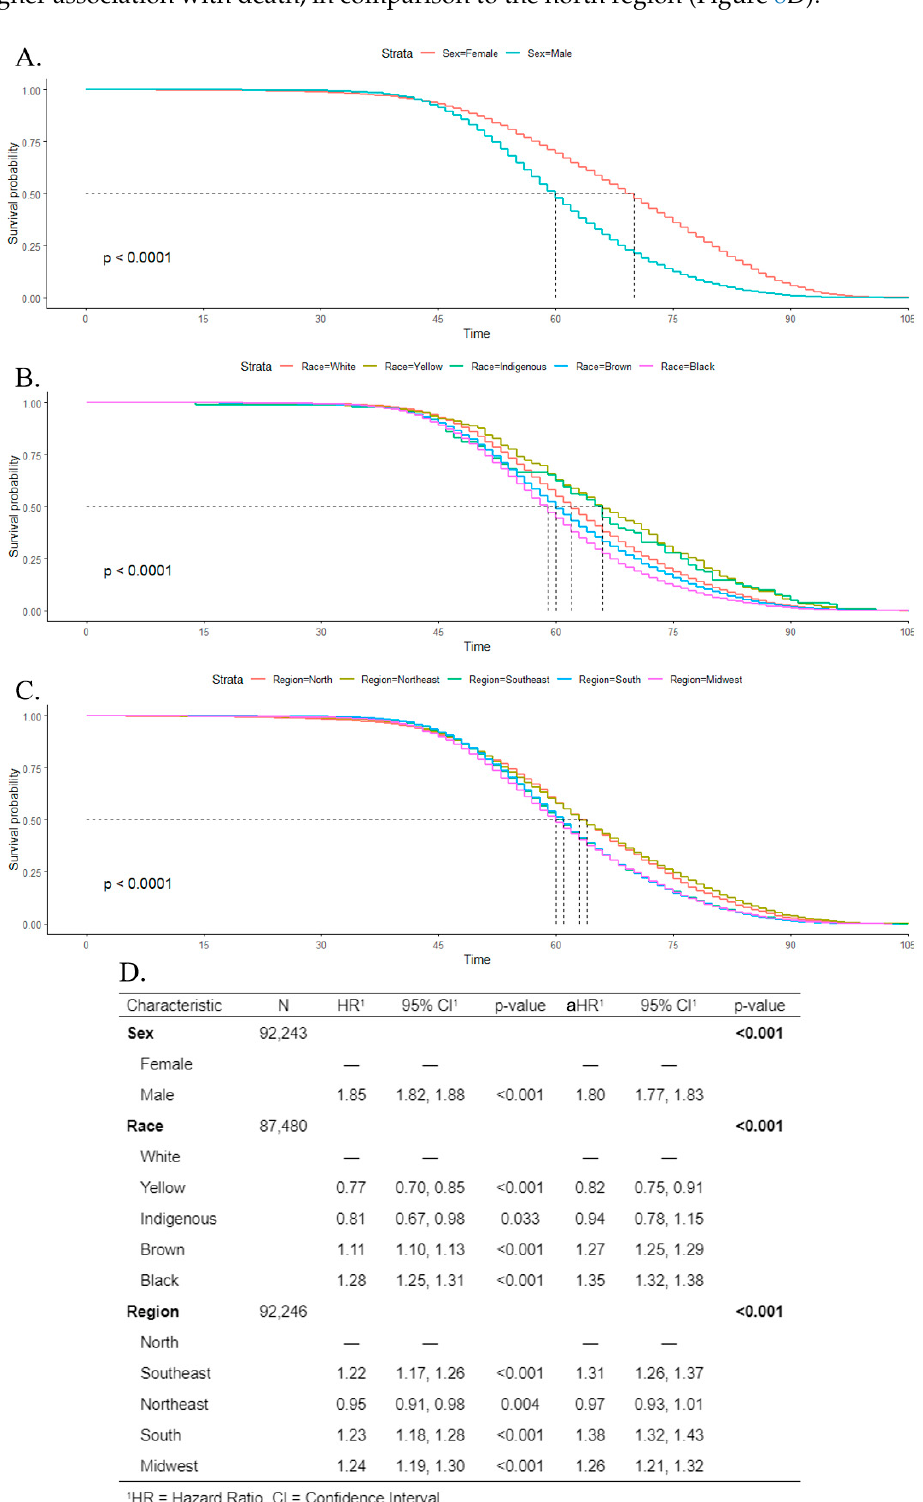
Figure 8. Kaplan–Meier survival rates for individuals with oral cancer according to sex ( A ), race ( B ), and geographic regions ( C ). Cox’s proportional hazards model for survival time with univariate (hazard ratio (HR)) and multivariate (adjusted hazard ratio (aHR)) models ( D ).